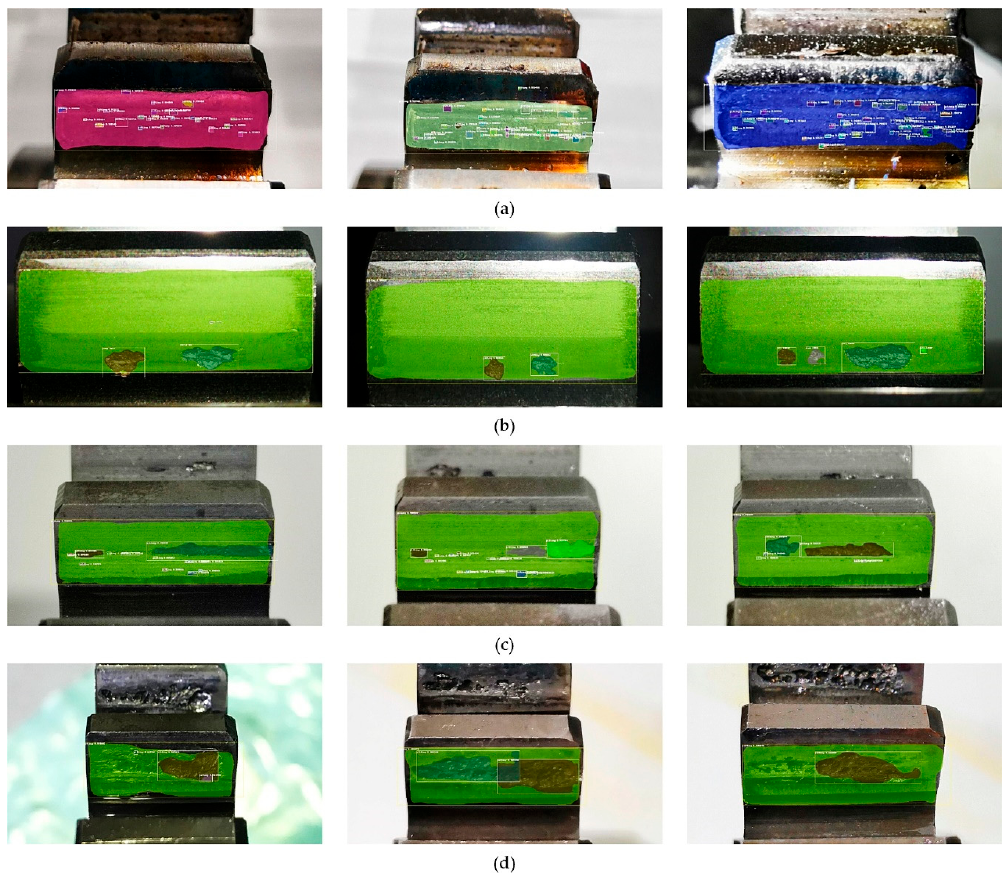
Figure 9. Detection results under different pitting levels. (a) Initial pitting; (b) Initial local pitting; (c) Moderate local pitting; (d) Severe local pitting.